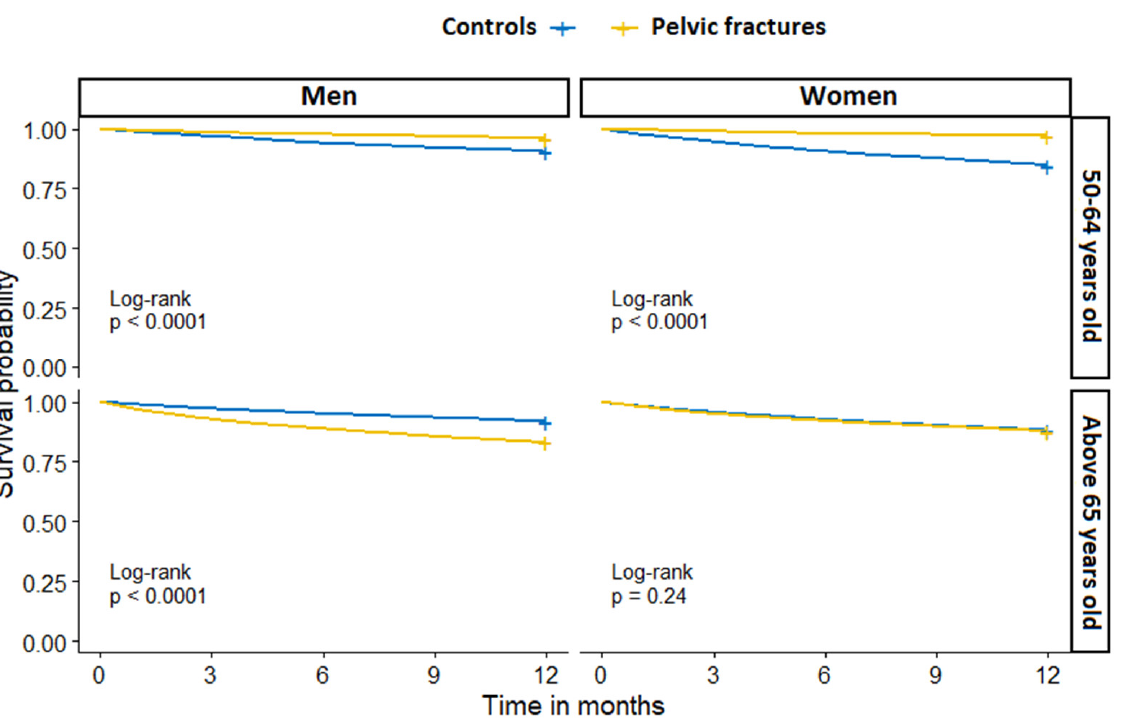
Figure 4. One-year all-cause mortality in patients with pelvic fracture and fracture-free controls, stratified by sex and age group.